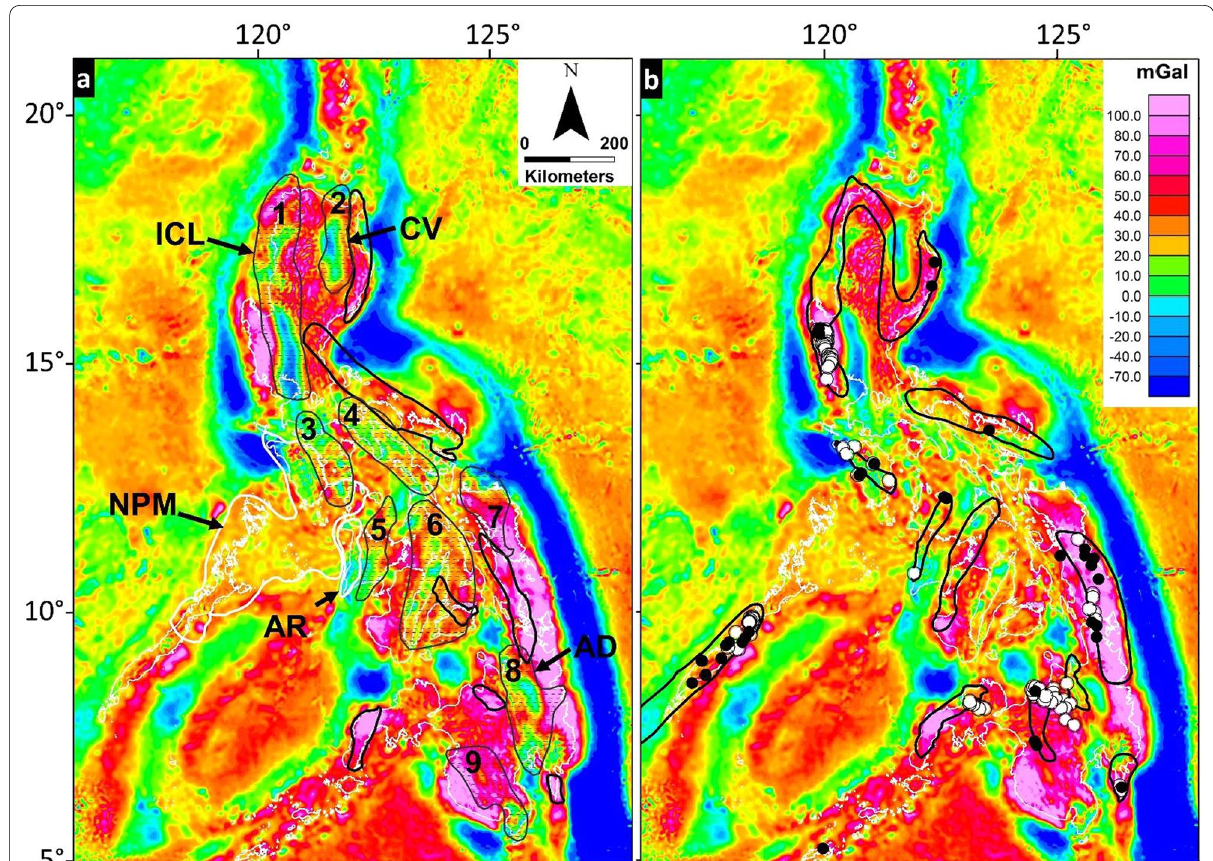
Fig. 4 Isostatic anomaly map of the Philippines showing the general distribution of a sedimentary basins (polygons with hachures), metamorphic rocks (heavy line polygons), and b ophiolitic rocks (modified from MGB 2010). Numbers represent the sedimentary basins of PMB affinity: 1 Ilocos-Central Luzon (ICL), 2 Cagayan Valley (CV), 3 Mindoro, 4 Southern Luzon-Bicol, 5 = = = = 8 Agusan-Davao (AD), 9 Cotabato (C). BS Bohol Sea, NPM Northern Palawan-Mindoro block (white polygon), AR = = = = symbolize the occurrences of nickel (black) and chromite (white) deposits in the Philippines (MGB